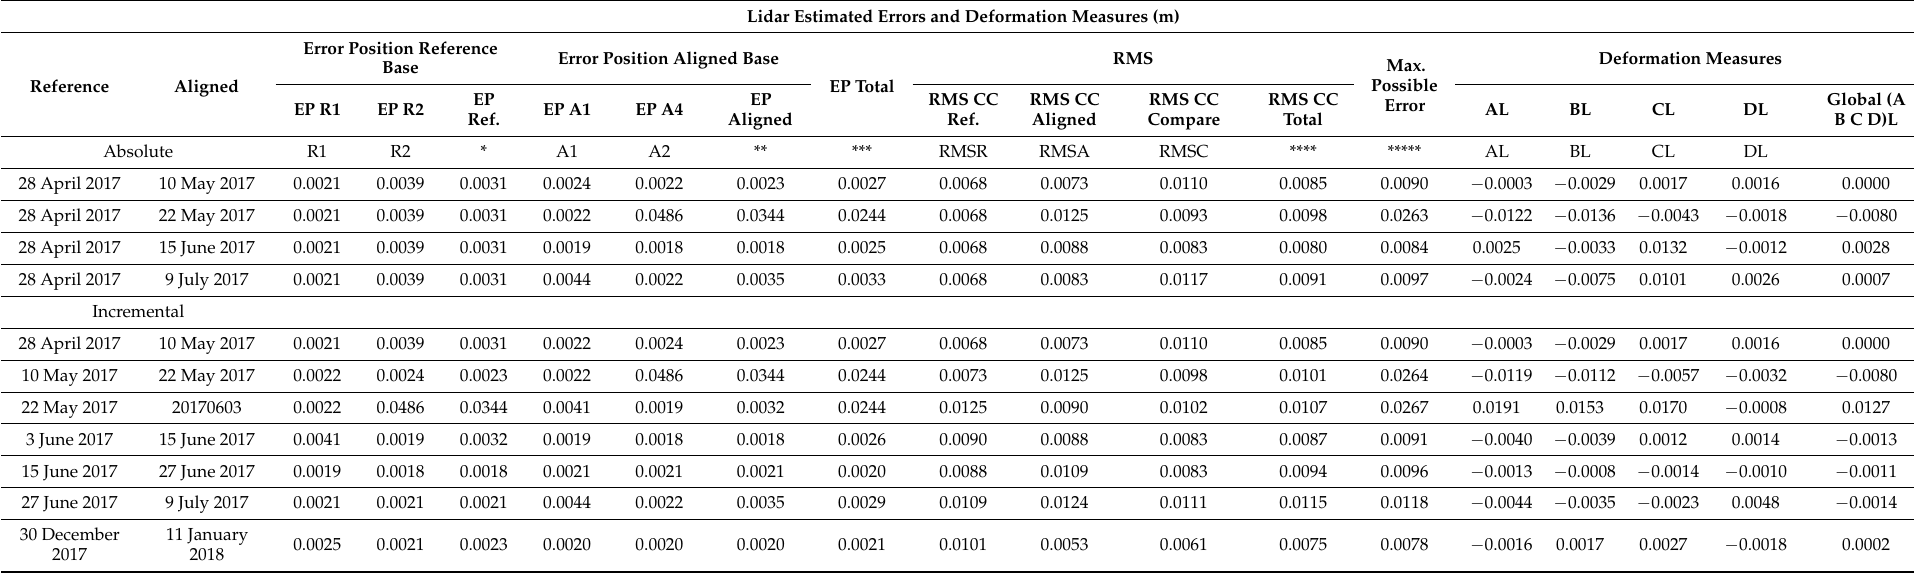
Table 4. Deformation and error measurements by comparing LIDAR